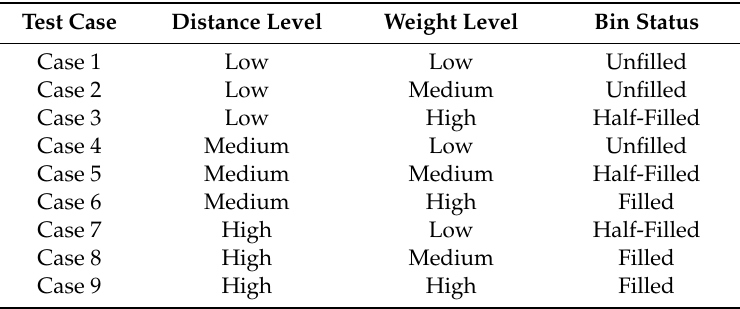
Table 4. Smart bin status for dataset